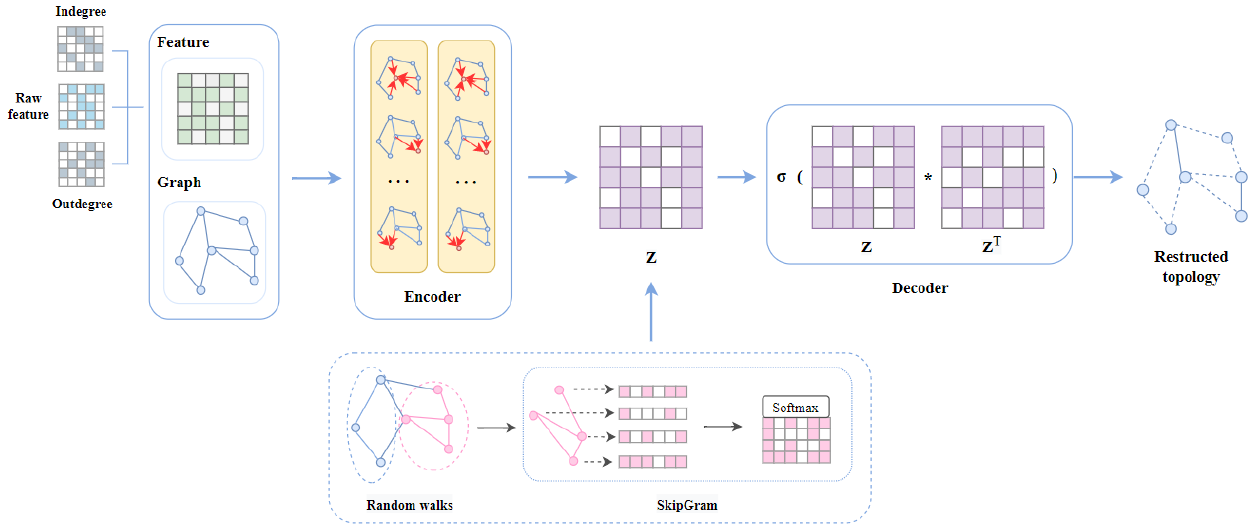
Figure 1. The RCAGE architecture. Our model takes in the graph structure and node attributes as inputs on the left side. The following component is an encoder that utilizes an attention mechanism to produce the embedding matrix Z, which is subject to random walk regularization. The last is the decoder and the loss calculation method.